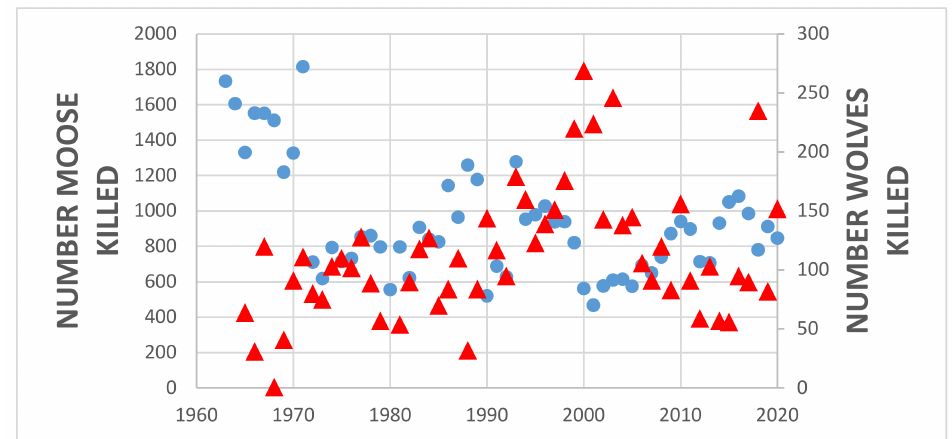
Figure 2. Hunter harvests of moose and hunter and trapper harvests of wolves in Game Management Unit 13, in south-central Alaska, USA (moose = blue circles; wolves = red triangles). Our statistical analysis includes data from 1973 onward.